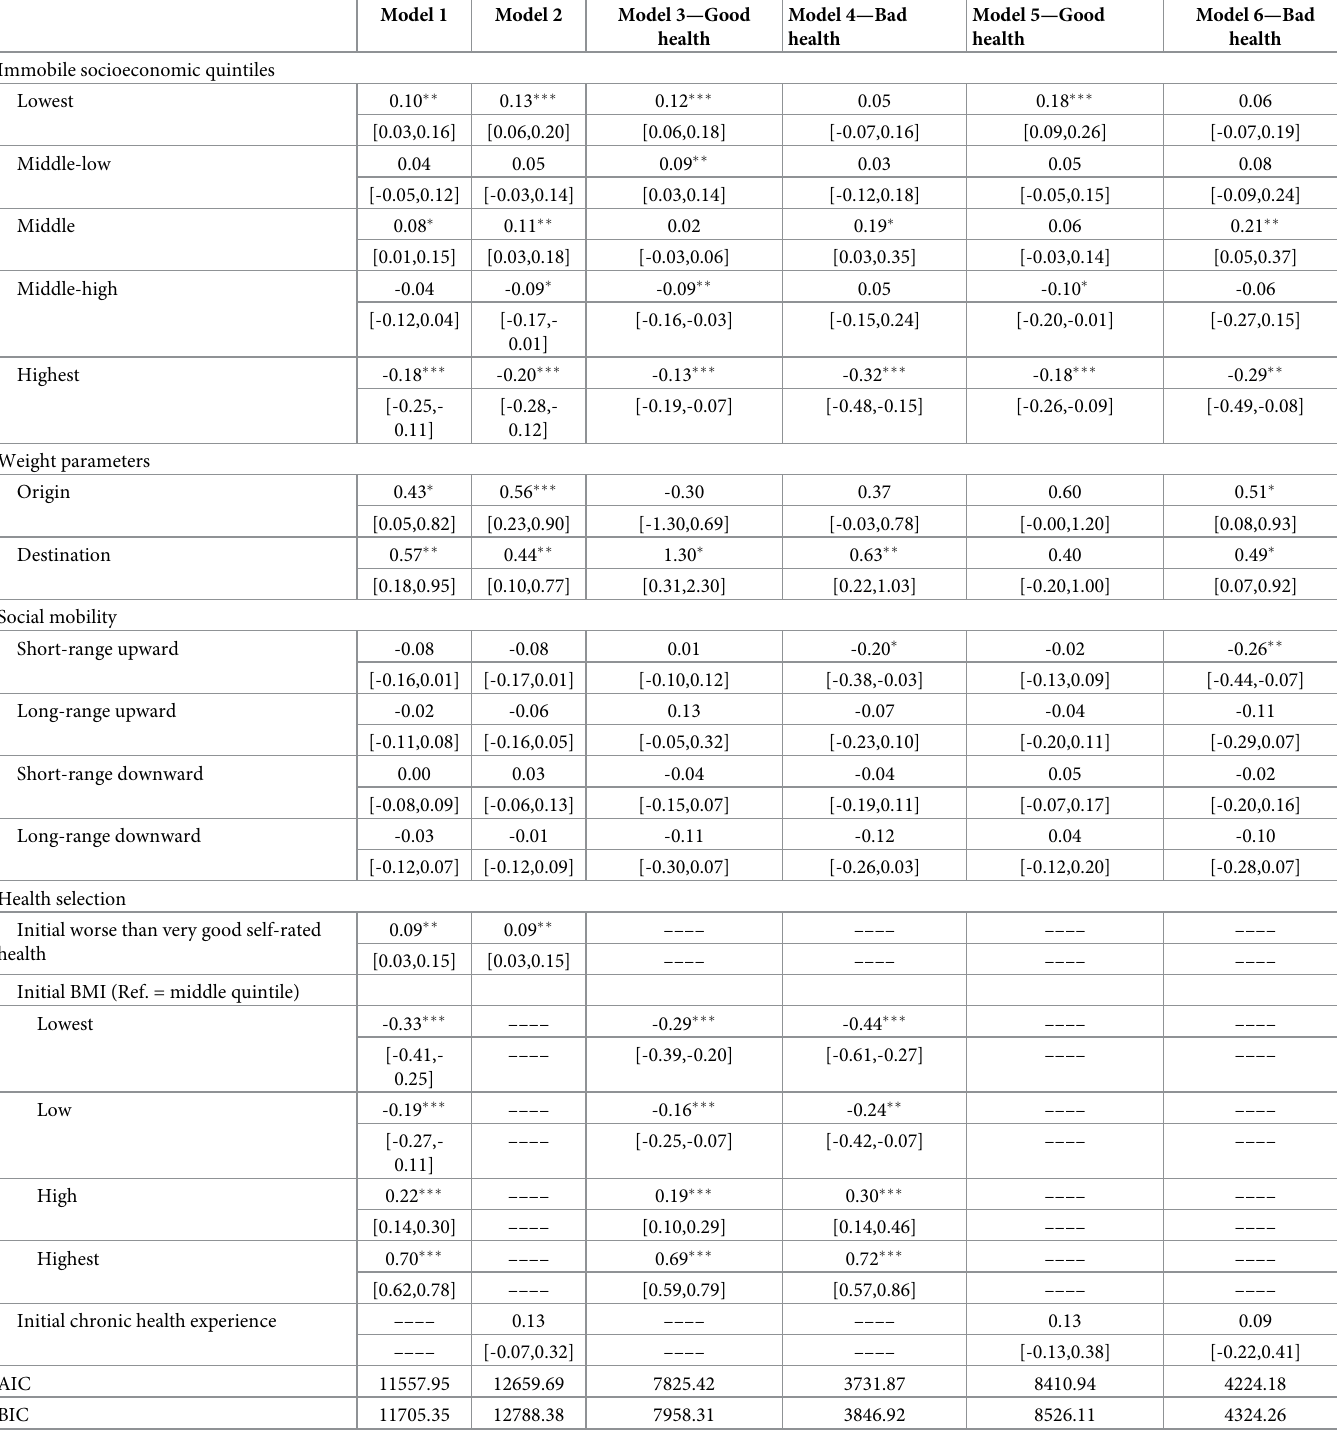
Table 5. Point estimates from DRM on AL levels with initial